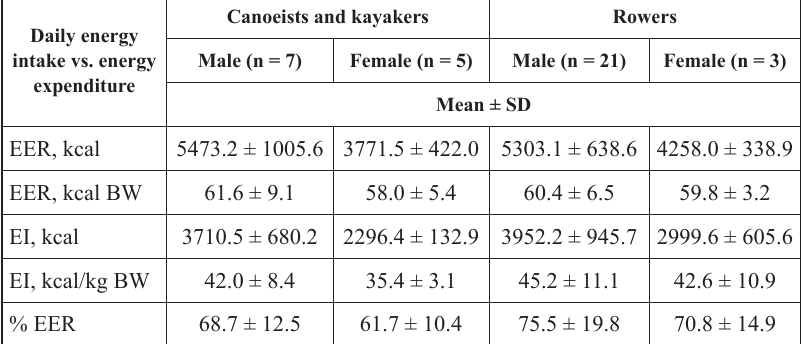
Table 3. Energy intake of Lithuanian